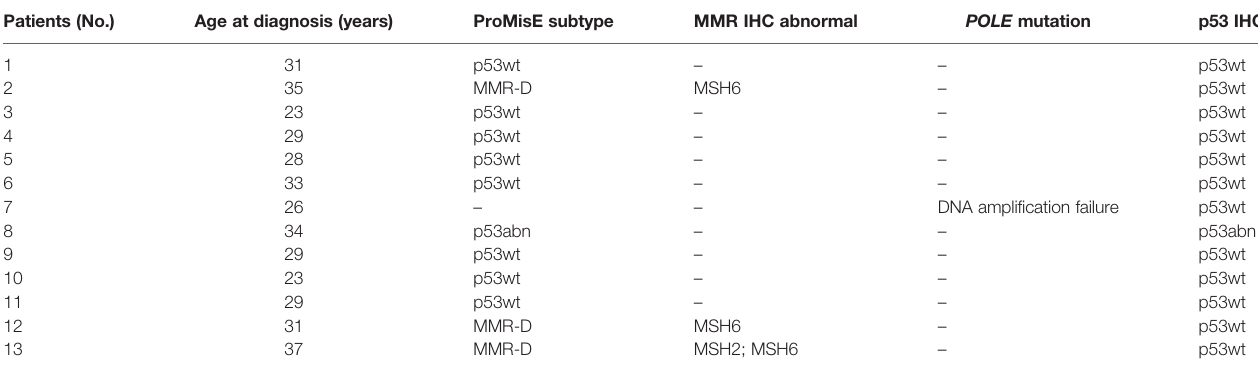
TABLE 2 | Molecular classi fi cation by ProMisE algorithm of all the patients. Patients